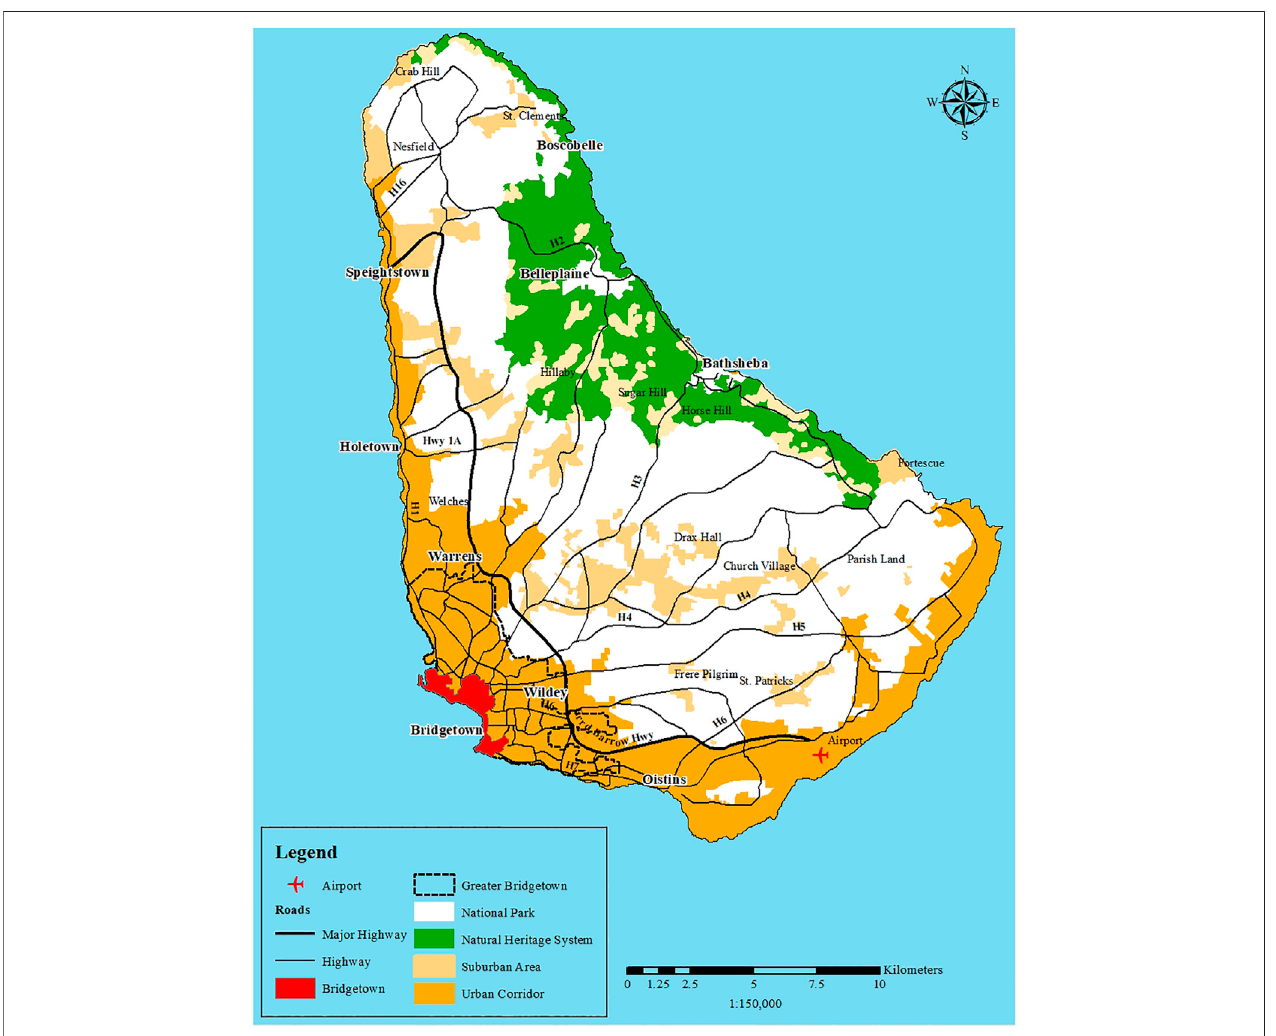
FIGURE 3 | Map showing the Four Main Urban Centers which constitute Greater Bridgetown (source: Rajesh Doodlal).